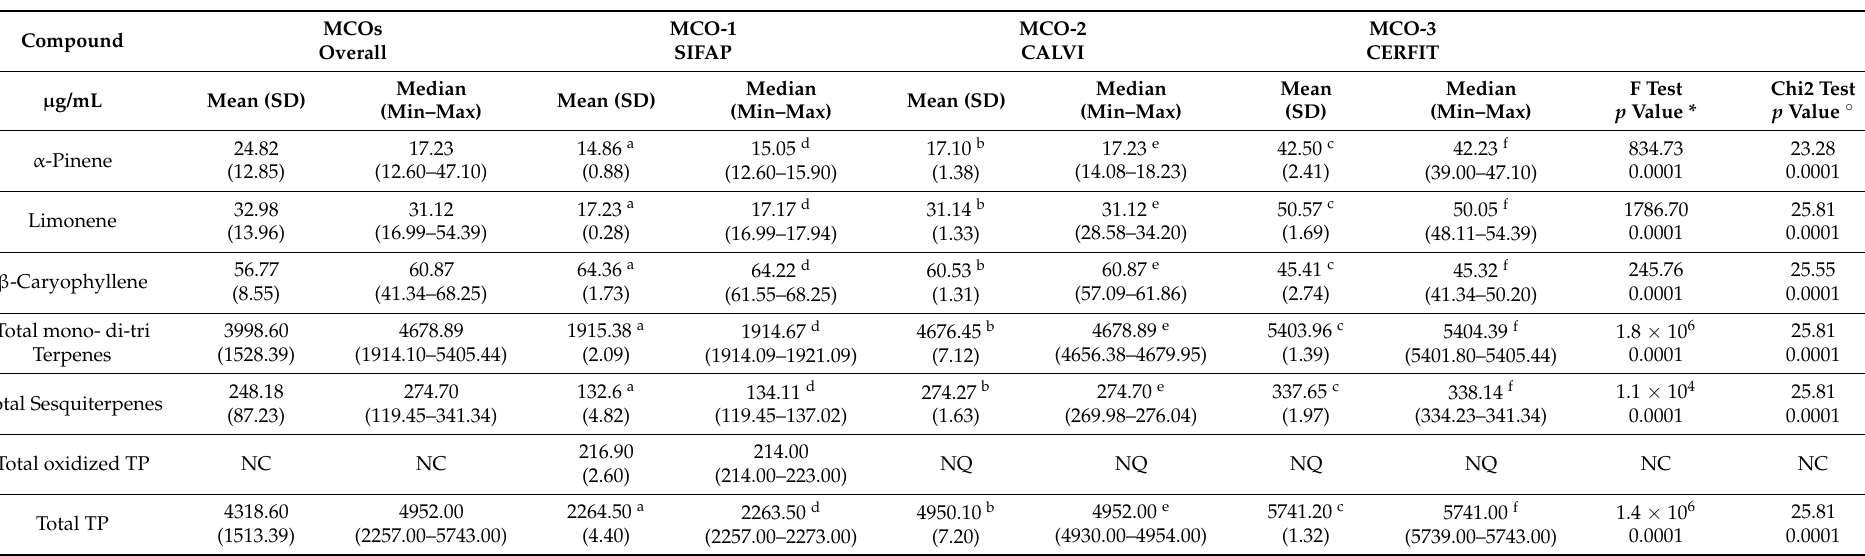
Table 8. Terpenes in MCO extracts. Data from ten separate experiments each performed in triplicate. Tukey-Kramer (for One-Way ANOVA) or Dunn (for Kruskal-Wallis test) post-hoc analyses were applied. Differences were considered significant when p < 0.05 and are indicated with different superscripts letters: in each line, values with a different letter (a, b or c for mean values; d, e or f for median values) are significantly different ( p <